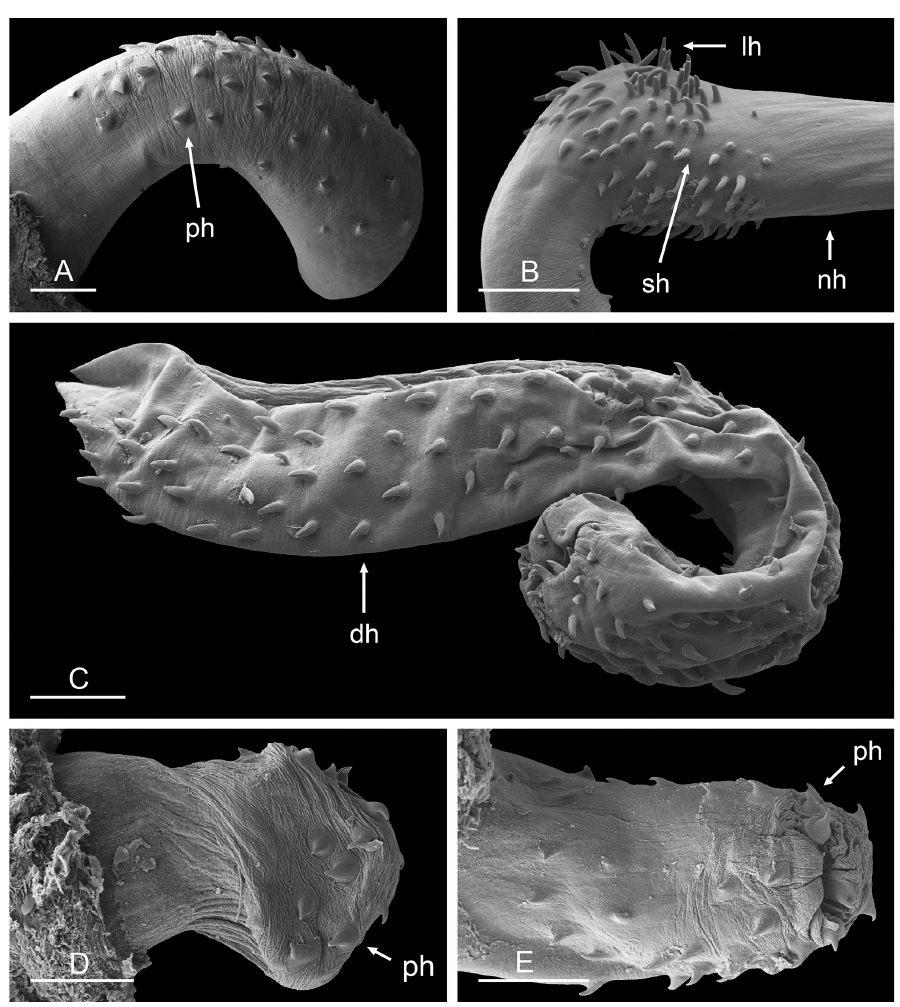
Figure 48. Evaginated penis, Wallaconchis graniferum , Philippines ( A–C ) Luzon [3163] (PNM 041227) ( D ) Bohol [3636] (PNM 041228) (E) Bohol [3638] (PNM 041225). A Proximal region of evaginated penis with hooks, scale bar 400 μm B Middle region of evaginated penis with long slender hooks on one side, and shorter hooks on the other side, scale bar 400 μm C Distal region of evaginated penis with distal hooks, scale bar 300 μm D Partially evaginated penis with proximal hooks (more distal hooks are inside the rest of the invaginated penis), scale bar 200 μm E Partially evaginated penis with most proximal hooks (more distal hooks are invaginated inside), scale bar 200 μm. Abbreviations (from proximal to distal): ph proximal hooks (first penial region) lh long slender hooks (second penial region) sh short hooks (sec- ond penial region) nh no hooks (gap) dh distal hooks (third penial